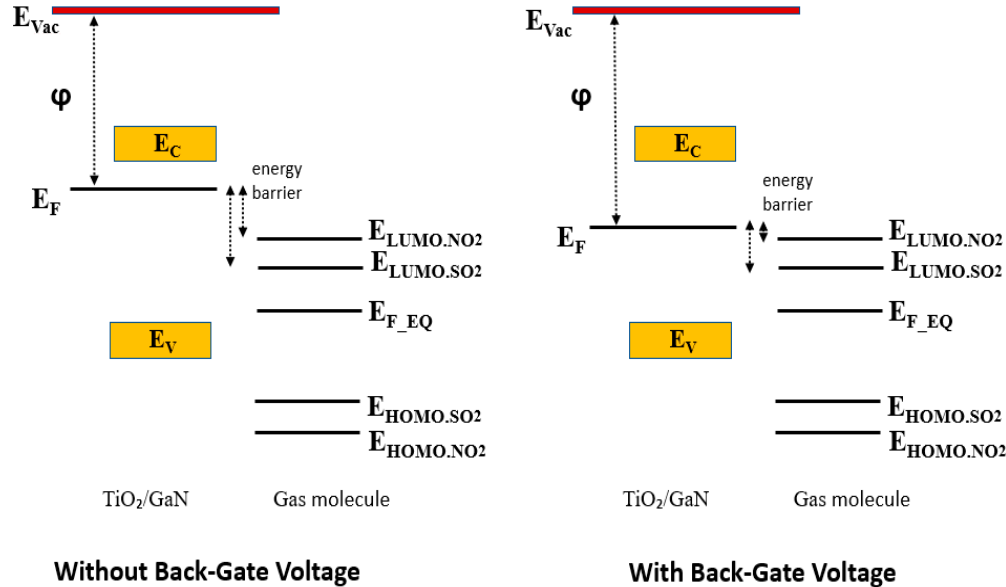
Figure 4. Schematic representation of the energy band diagram showing energy barriers between the TiO 2 /GaN nanocom- posite and the gas molecule. Here, ϕ , E C , E V , and E F represent work function, conduction band, valence band, and Fermi energy of TiO 2 /GaN, respectively, E Vac denotes the energy of vacuum level, and E F_EQ represents the equilibrium state of the adsorption system. E LUMO and E HOMO indicate the orbital energies of the gas molecules. LUMO=lowest unoccupied molecular orbital; HOMO= highest occupied molecular orbital. Table 1. Fermi energy, molecular frontier orbital energies, and energy differences. E F-LUMO is the absolute value calculated by E F (device)-E LUMO (gas). E F-HOMO is the absolute value calculated by E F (device)-E HOMO (gas). Adsorption